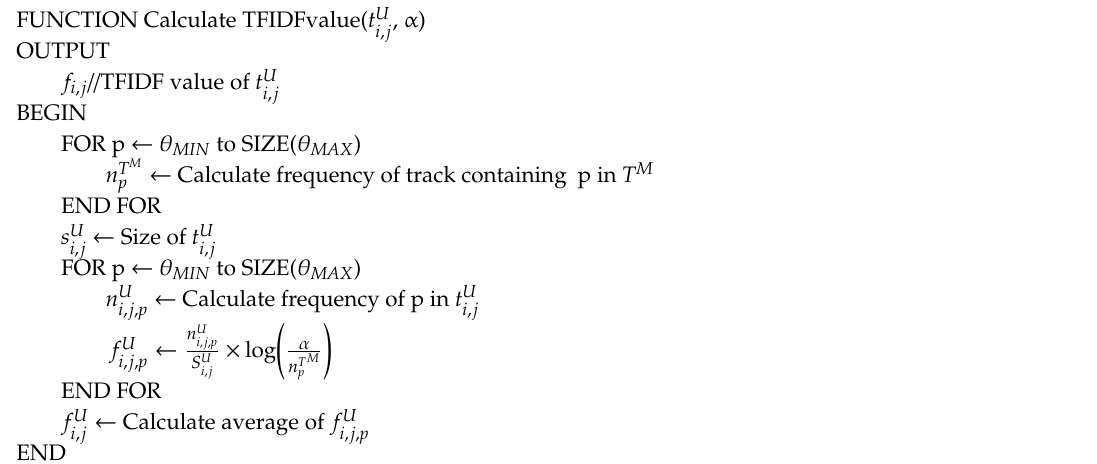
Algorithm 1. Term frequency–inverse document frequency (TFIDF) value calculation